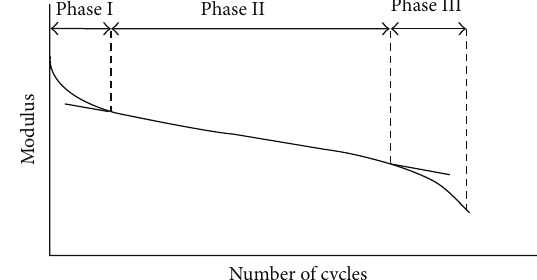
Figure 15: The three phases of fatigue test